Question: Write a single sentence explaining what this figure depicts.
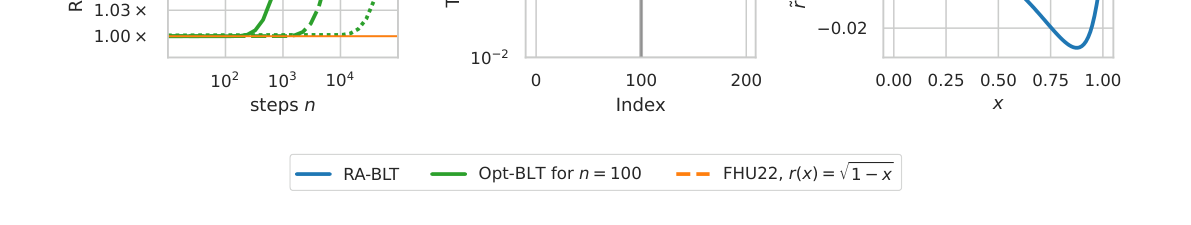
Answer: (Left column) Comparison of three fixed Opt-BLT mechanisms across a range of n (extending beyond the optimization targets). (Center) Comparing the first 200 Toeplitz coeffi- cients defining the C and B matrices for Opt-BLT and RA-BLT for degree d = 2, with the Opt-BLT mechanism optimized for n∗= 100. (Right) Differences in the generating functions for the Opt-BLT and RA-BLT factorizations of the middle column.